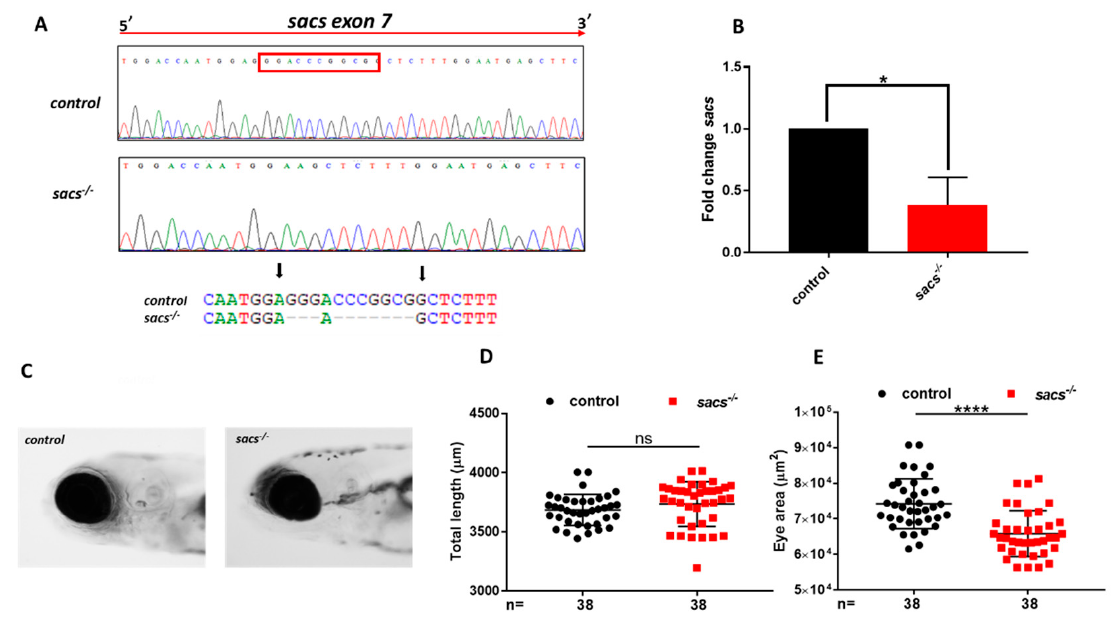
Figure 1. Generation of sacs-null mutant zebrafish. ( A ) Sequencing chromatographs of control and sacs-null mutant ( sacs − / − )specimens and alleles. The red rectangle define frameshift mutation in exon 7. The arrow indicates the area of the induced deletion. ( B ) qRT-PCR analysis revealed a decrease in the level of sacs mRNA expression, normalized to β -actin. Three independent RNA samples from sacs − / − mutant larvae at 120 hpf and from controls were analyzed. * p ≤ 0.05, calculated by Student’s t -test. ( C ) Lateral view photographs of representative control and sacs − / − specimens. ( D ) No dysmorphology and full length was noted at 120 hpf, but ( E ) homozygous larvae showed slight but significant “microphthalmia”, **** p ≤ 0.00001, calculated by Mann-Whitney test. The values are expressed as mean ± standard deviation (SD). Abbreviations: n , total number of evaluated embryos; error bars indicate standard errors of the means; ns, not